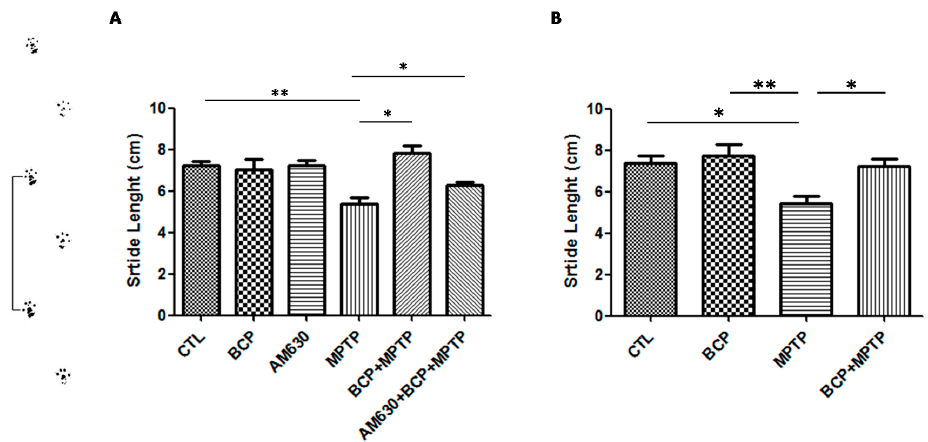
Figure 2. The gait test. The protective effects of BCP administered both intraperitoneally ( A ) and orally ( B ) against MPTP-induced behavioural impairment in mice. The MPTP-lesioned mice